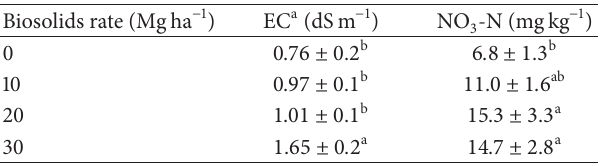
Table 2: Chemical soil properties at 0–15 cm depth (mean ± SE) one month after biosolids application at an abandoned field in Chihuahua, Mexico.